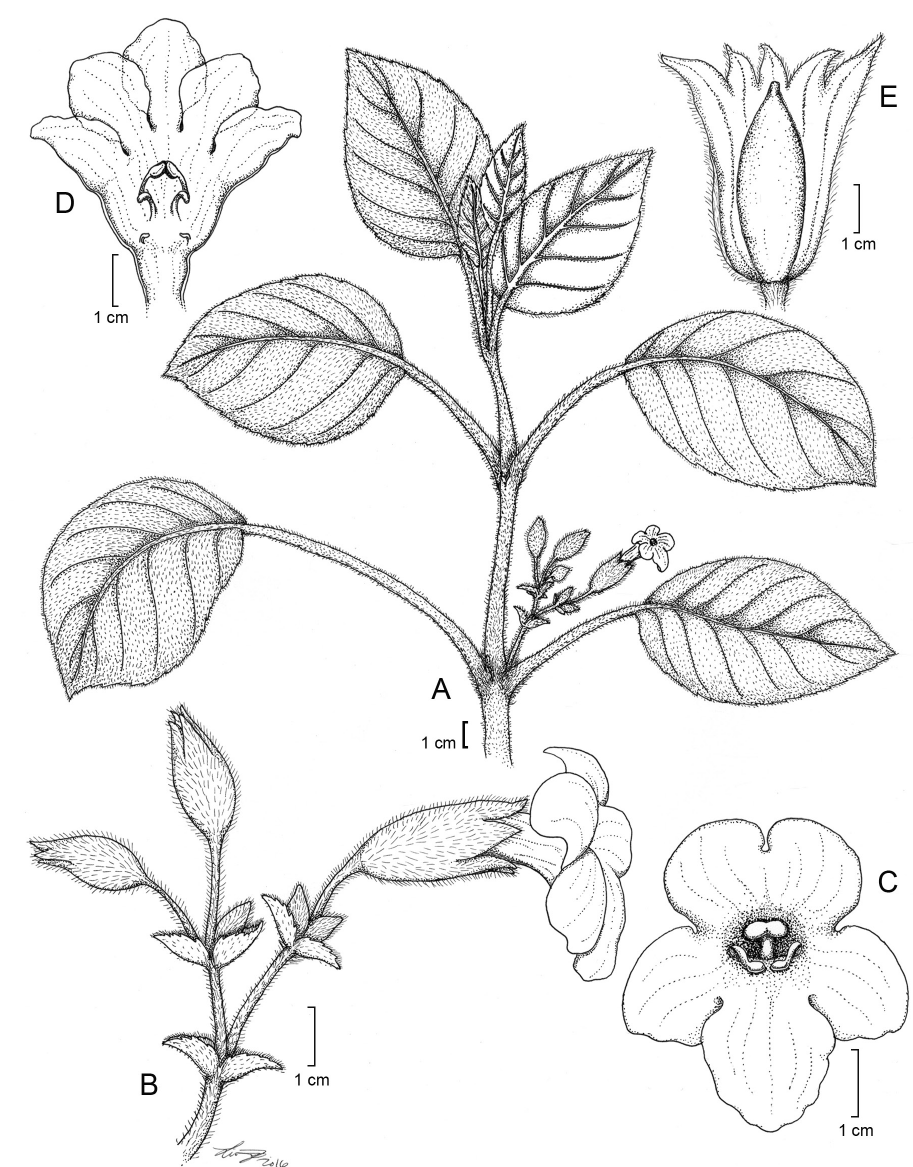
Figure 5. Cyrtandra hispida M.A.Johnson. A Habit B Inflorescence C Corolla, anterior view D Co- rolla, longitudinal section E Calyx, longitudinal section and young fruit. Drawn from Johnson 91 (RSA, SUVA), Johnson 212 (SUVA), Johnson 215 (RSA), and field images. Distribution and ecology. Cyrtandra hispida is only known from two populations in the upland rainforests of Taveuni, Fiji, where plants occur on exposed hillsides composed of volcanic cinders, and on rocky stream banks from 697–1126 m elevation (Fig.